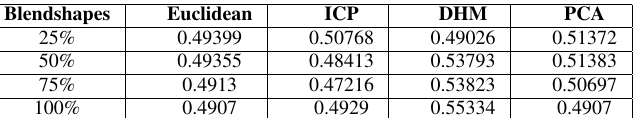
TABLE III R ESULTS IN MILLIMETERS OF THE PROCESSING OF RANDOMLY GENERATED SETS OF BLENDSHAPES .